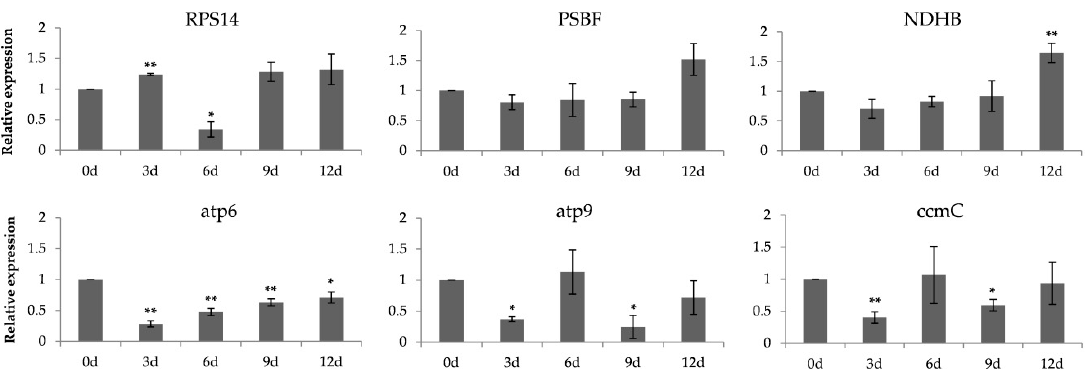
Figure 8. Expressions of three plastid (RPS14, PSBF, and NDHB) and three mitochondrial genes (atp6, atp9, and ccmC) in poplar on the 0, 3rd, 6th, 9th, and twelfth day after drought tolerance. Data were normalized to UBQ gene. The sample without drought treatment was defined as 1 in the figure. The data were presented as the mean ± SE of three separate measurements. Asterisks denote significant differences: * p < 0.05; ** p < 0.01.